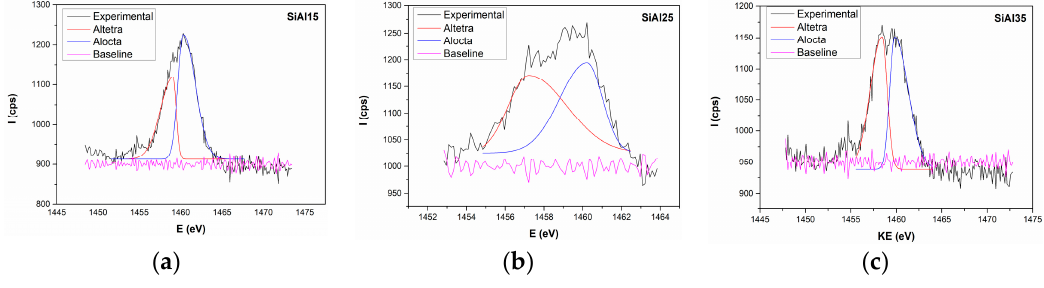
Figure 6. Al KLL signals of the calcined samples (XPS spectra): ( a ) SiAl15; ( b ) SiAl25, and ( c ) SiAl35.